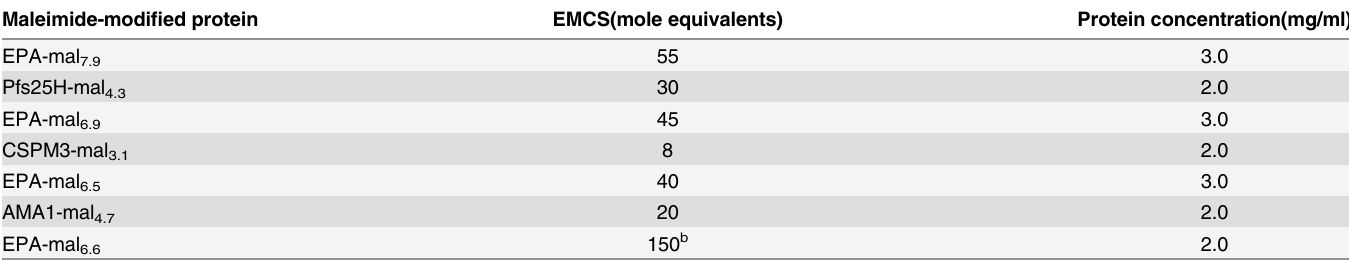
Table 2. Maleimide-modification reaction parameters a .